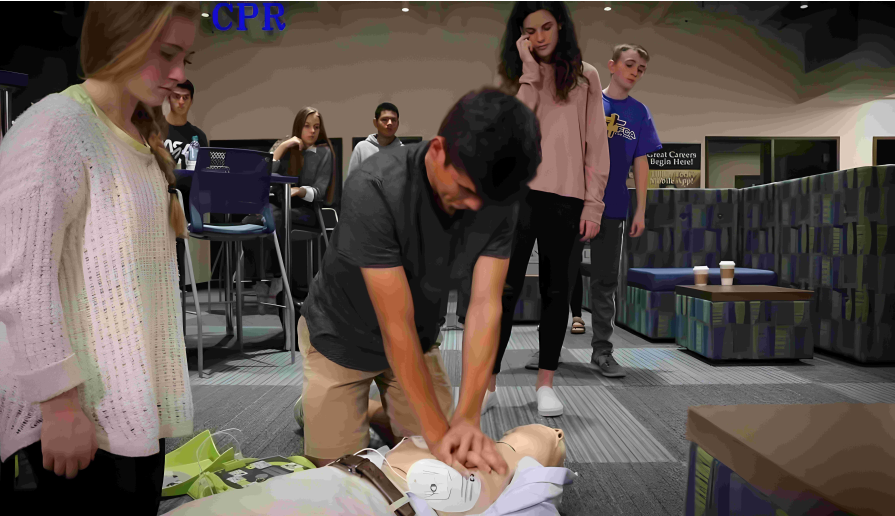
Figure 14. CPR recognition results in a more complex